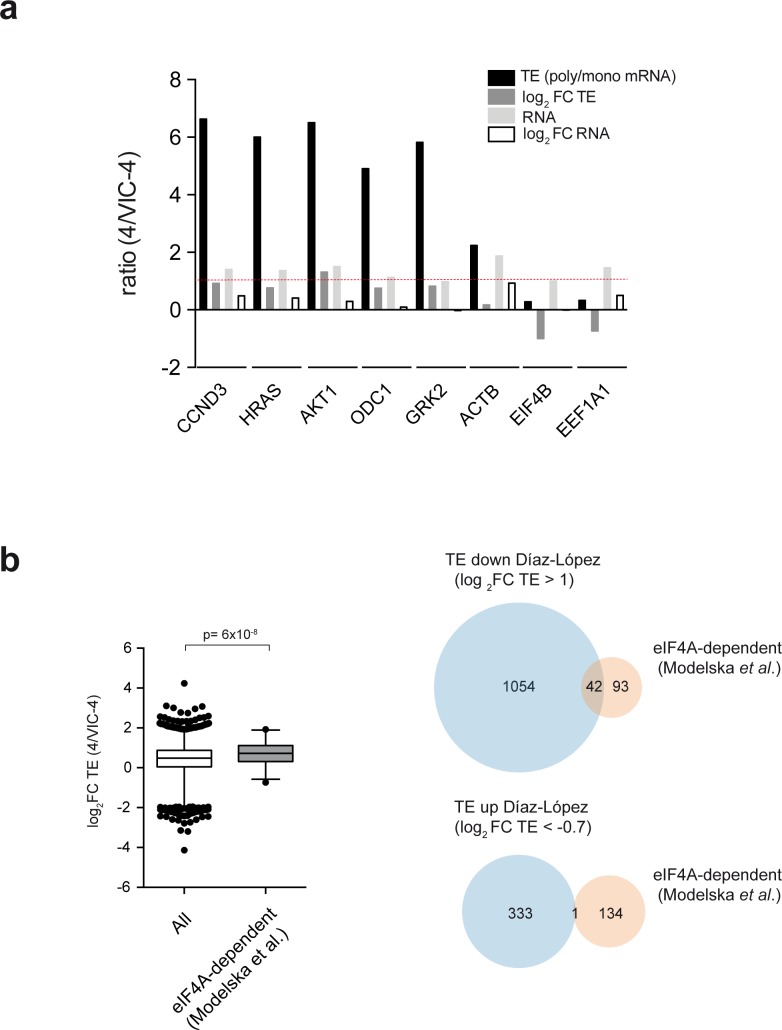
Raw and processed data for representative mRNAs and analysis of the functional overlapping between ES6S region and eIF4A.(a) Data for representative mRNAs of the ‘TE down’ and ‘TE up’ groups extracted from the polysome profiling dataset. Log2 FC TE, log2 FC RNA and the unprocessed ratio of polysomal/monosomal mRNA and total mRNA are shown (TE). (b) (Left) The mRNAs reported to be susceptible to eIF4A downregulation (Modelska et al., 2015) were selected, and the corresponding log2 FC TE values for 135 of them were extracted from our dataset and compared with those of all of the mRNAs in our analysis. The p-value after U test is shown (left panel). (Right) Venn diagram showing the overlap between ES6S blockage (blue) and eIF4A silencing (orange). About half of the eIF4A-dependent mRNAs were also affected by ES6S blockage (Log2 FC TE > 1) (right panel).